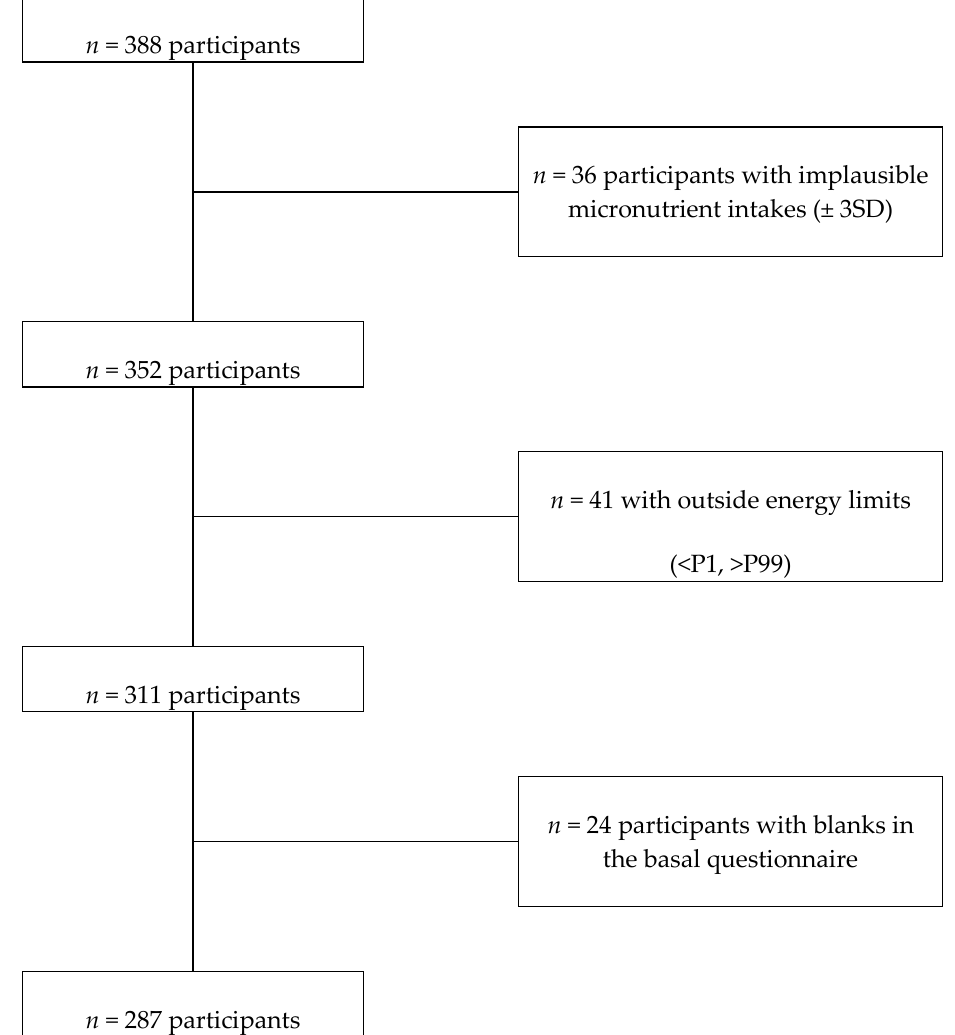
Figure 1. Flow-chart of participants recruited in the SENDO project, 2014-2017.